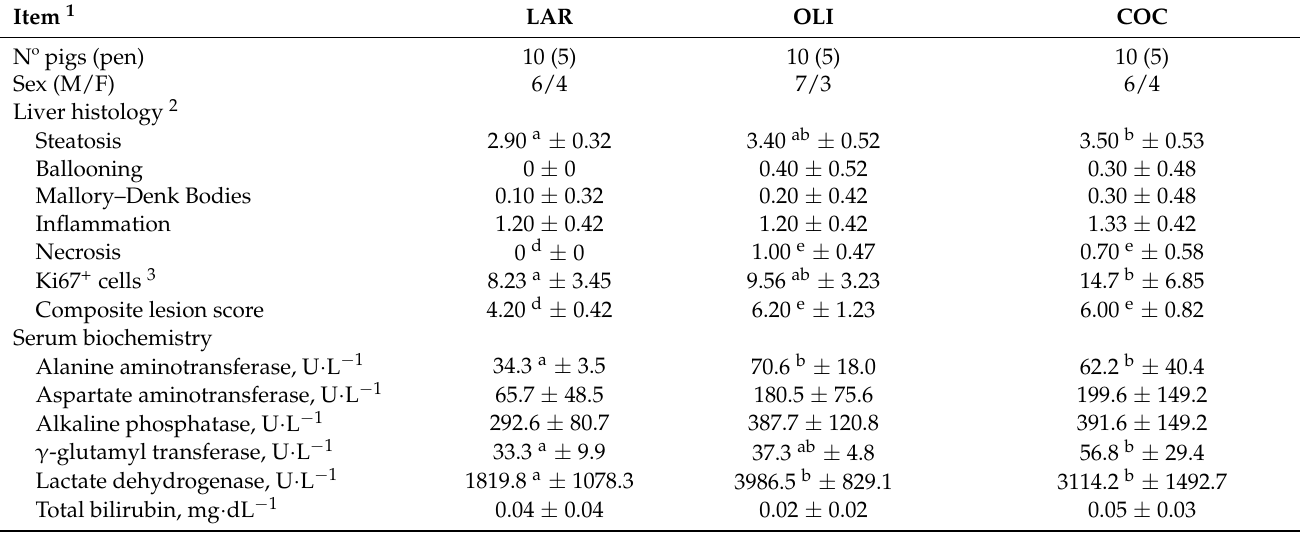
Table 2. Serum biochemistry and quantitative assessment of hepatic histology in juvenile Iberian pigs fed LAR, OLI, and COC diets for 10 consecutive weeks. COC, coconut oil diet; LAR, lard diet; OLI, olive oil